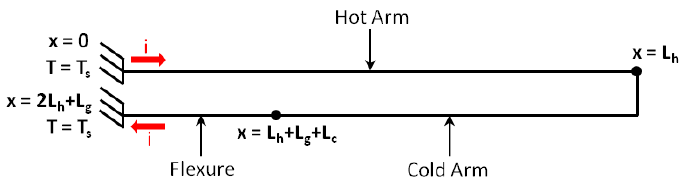
Figure 6. Simplified 1D model of the actuator, showing the direction of the current, i . The anchor pads are represented by fixed supports that are assumed to be at the same temperature of the substrate, T s